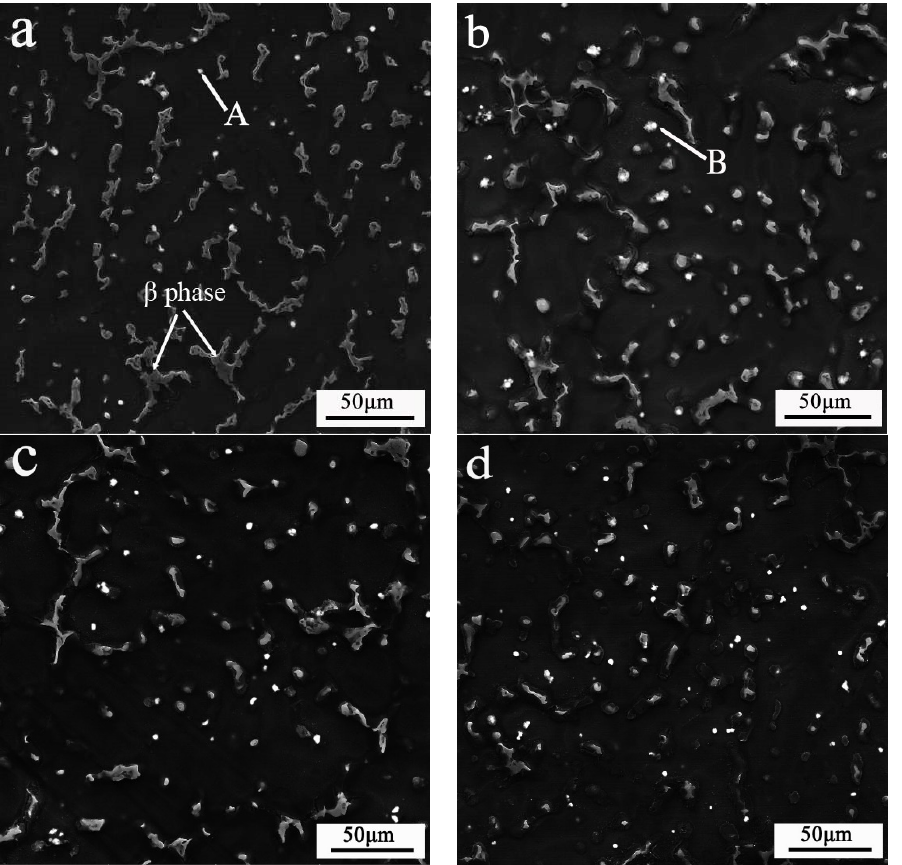
Figure 2. SEM images of AZ91–xSm magnesium alloys treated by ultrasonic vibration, where x = ( a ) 0 wt %; ( b ) 0.5 wt %; ( c ) 1 wt %; ( d ) 1.5 wt %.